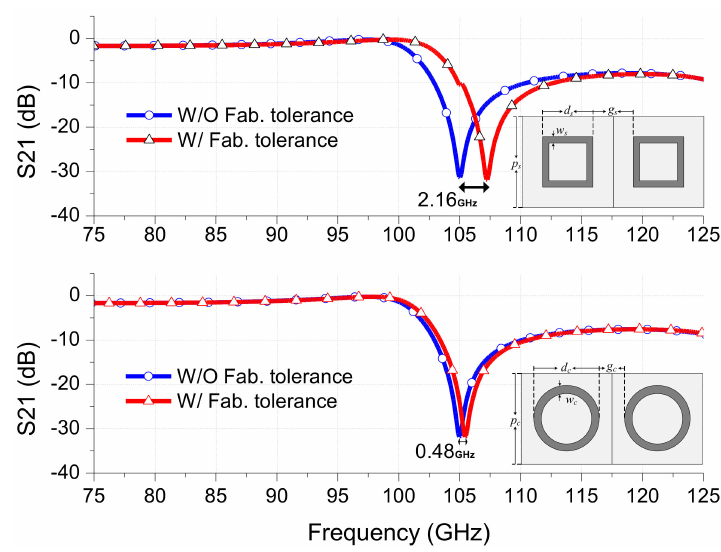
Figure 8. Influence of fabrication tolerances on the FSS frequency